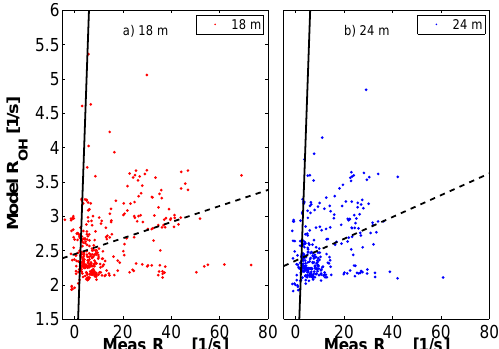
Figure 13. Scatter plots of the measured versus the modelled reac- tivity of OH at 18 (a) and 24m (b) . The solid lines indicate the 1:1 reference line, whereas the broken lines represent the least-squares